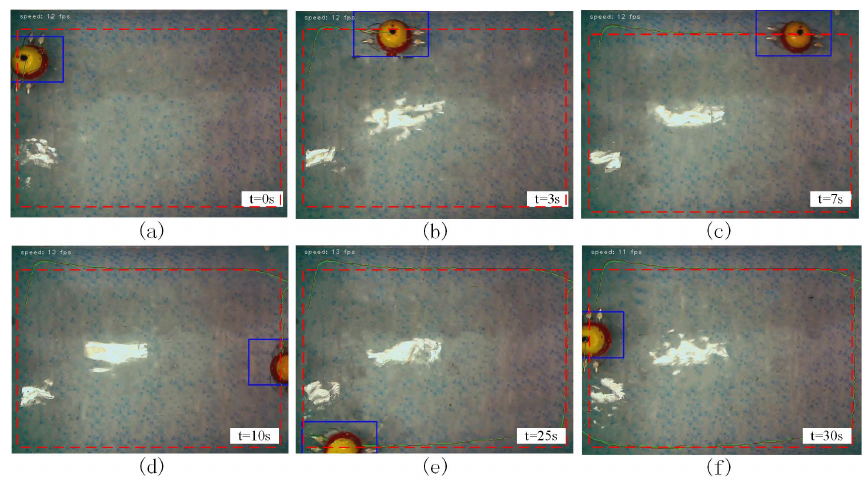
Figure 22. Image sequences of the BSR tracking a square trajectory.